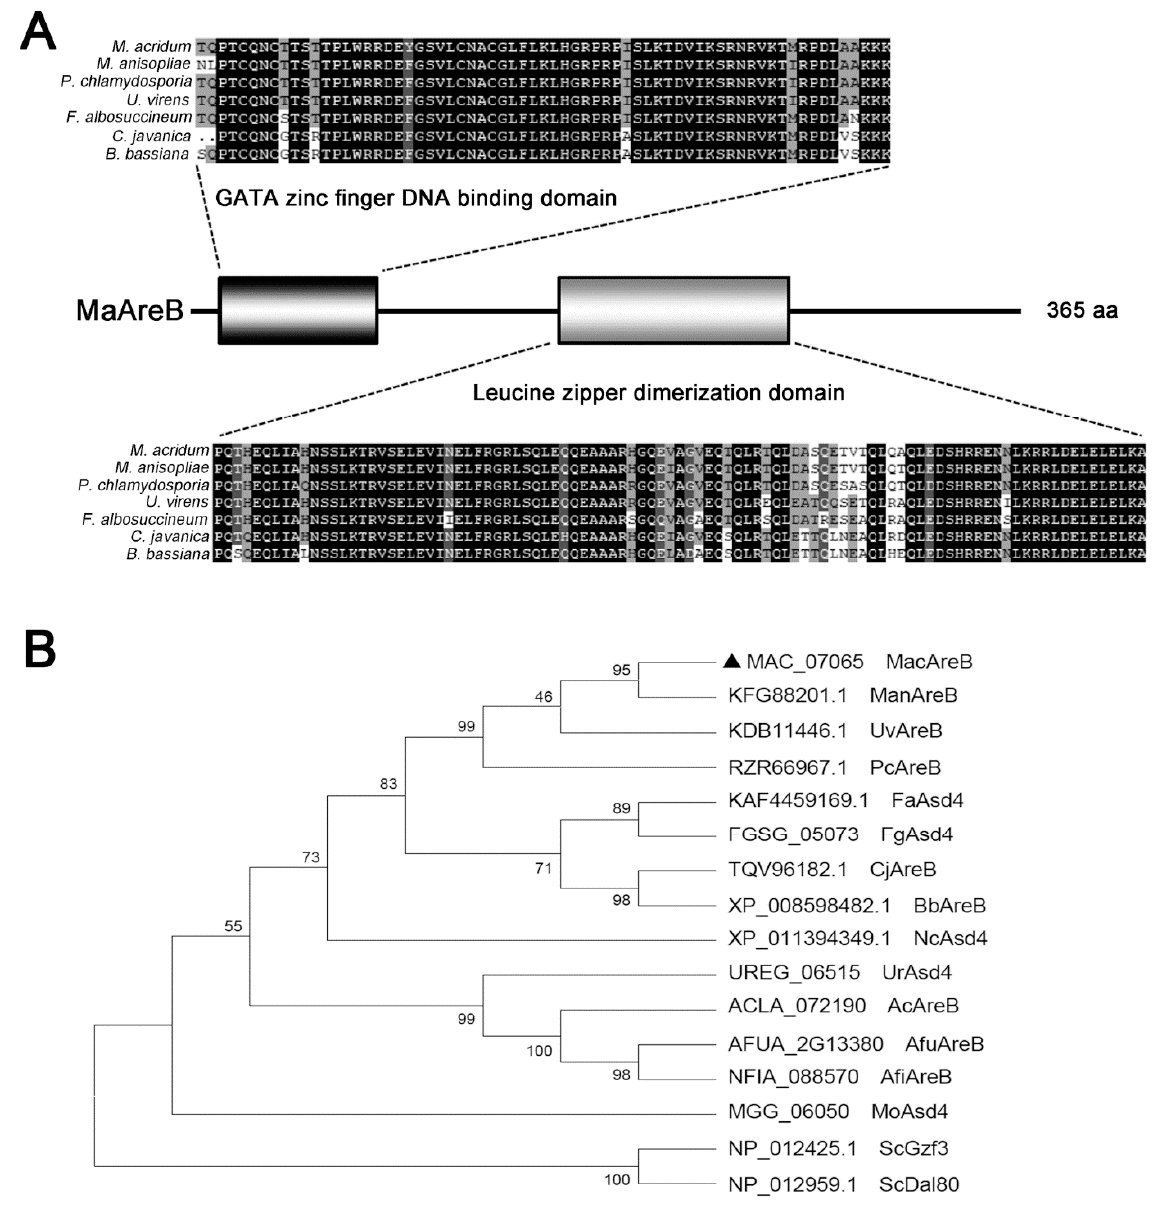
Figure 1. Sequence and phylogenetic analysis of MaAreB. ( A ) Conserved domain arrangements of the MaAreB and its orthologues in other fungal species. ( B ) Phylogenetic tree analysis of AreB proteins in multi-species. AreB, Asd4, Gzf3 and Dal80 are orthologues. Mac , Metarhizium acridum . Man , Metarhizium anisopliae . Uv , Ustilaginoidea virens . Pc , Pochonia chlamydo-